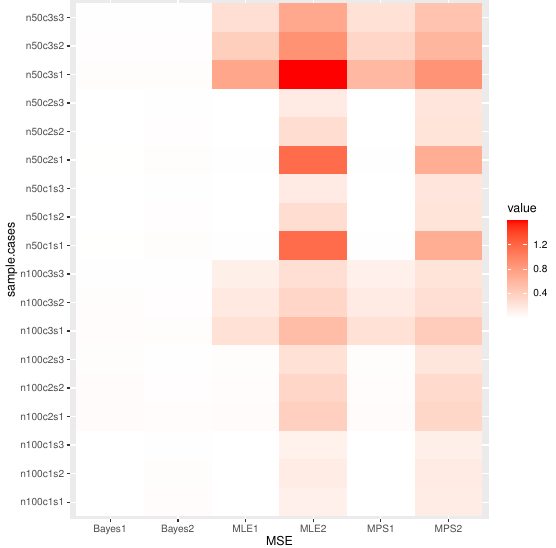
Figure 6. Heat maps of MSE